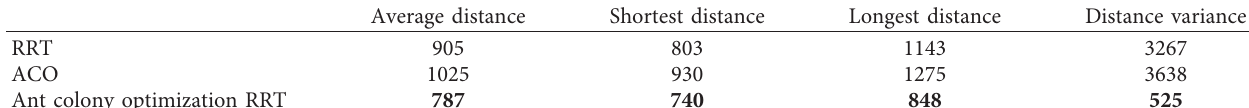
Table 2: The stability of the three algorithms under map 1 (distance).